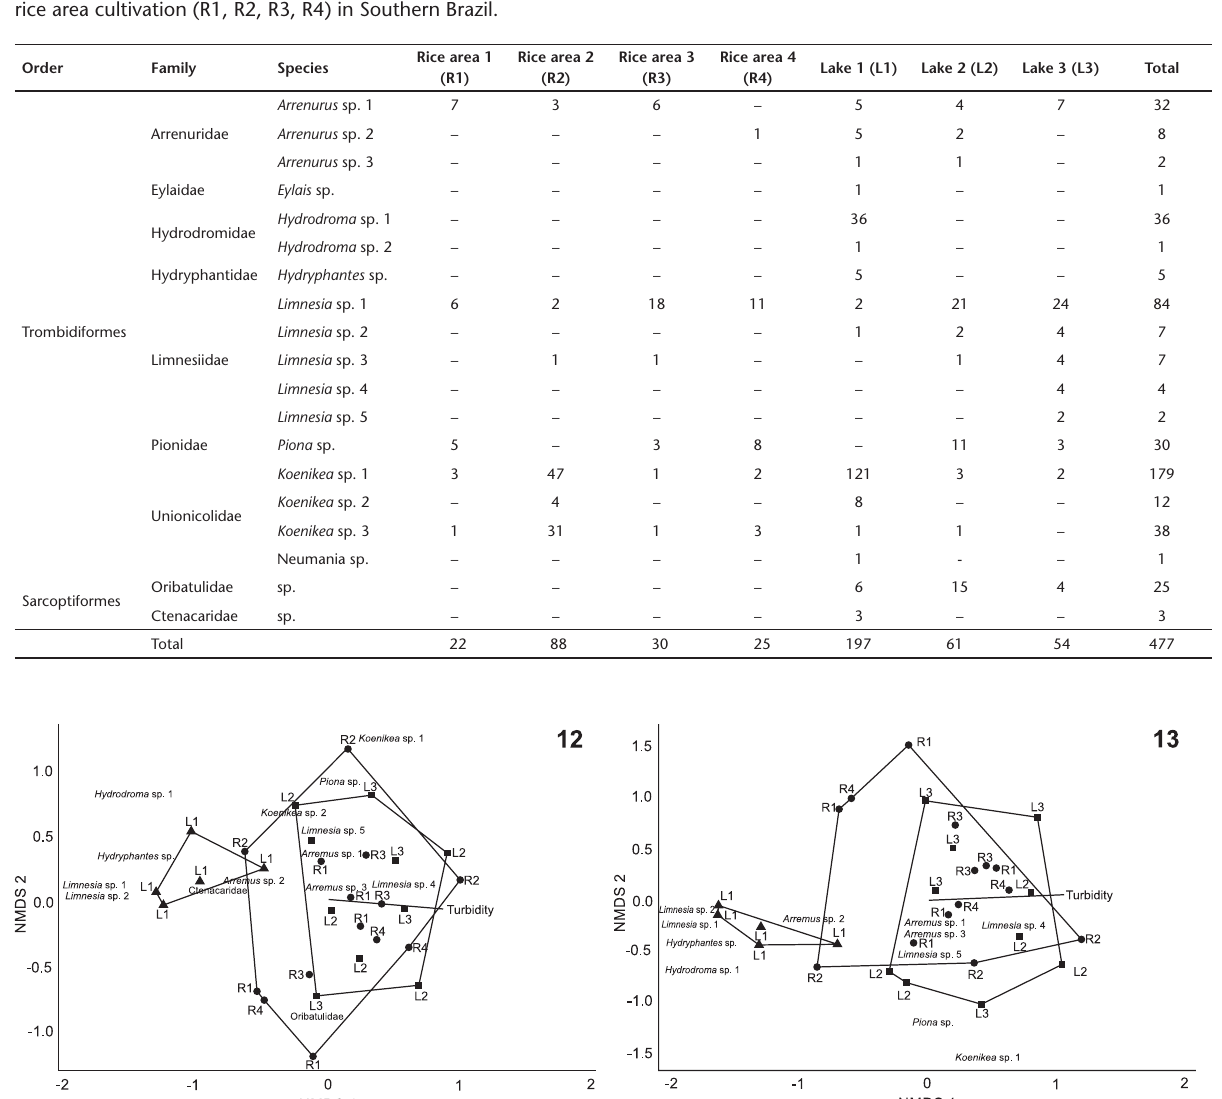
ues of abundance R1-R4 and at L2-L3, Ctenacaridae (Contrib.% 16.07) and Hydryphantes sp. (Hydryphantidae) (Contrib.% 10.31) contributed the most to the dissimilarity among